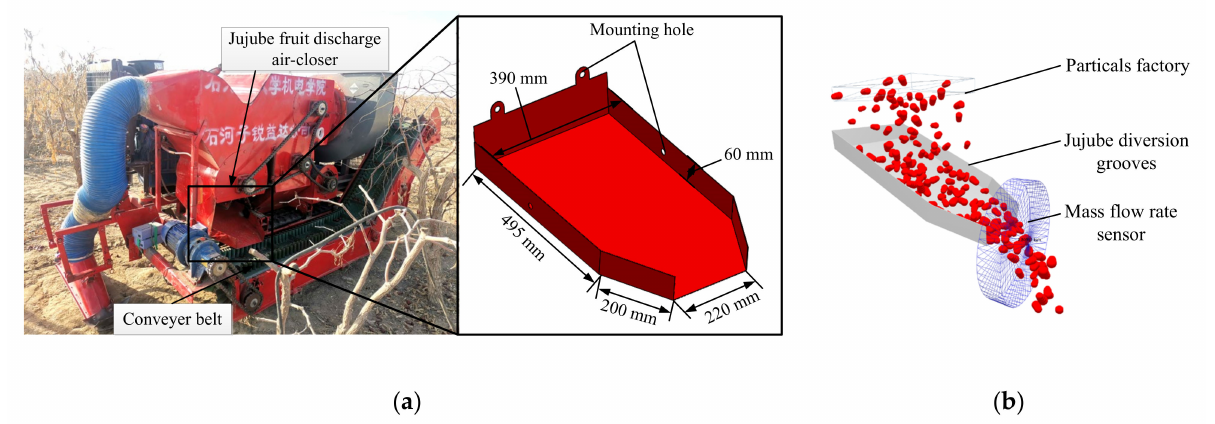
Figure 8. The flow rate simulation tests of fallen jujube fruit (FJF) using the jujube guide groove; ( a ) placement and structural dimensions of the FJF guide groove, ( b ) simulation tests of the flow rate.